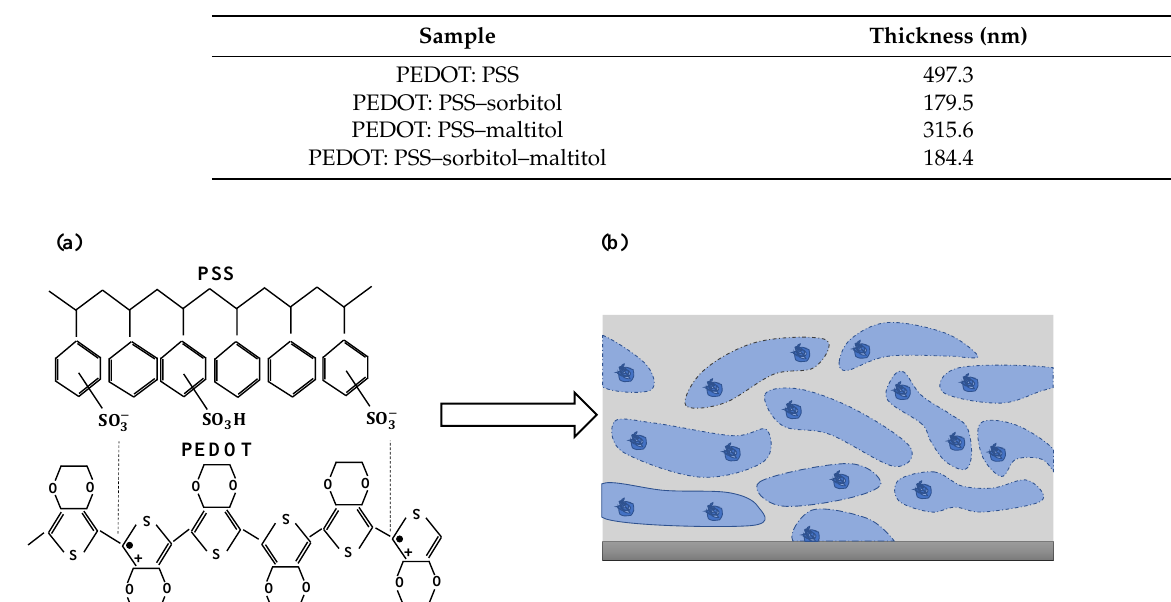
Figure 5. PEDOT: PSS structure and morphology: ( a ) PEDOT: PSS molecular structure and ( b ) re- sultant film with the PEDOT: PSS-rich (blue) and PSS-rich (grey) phases. Table 2. The thicknesses of PEDOT: PSS doped with organic additives.